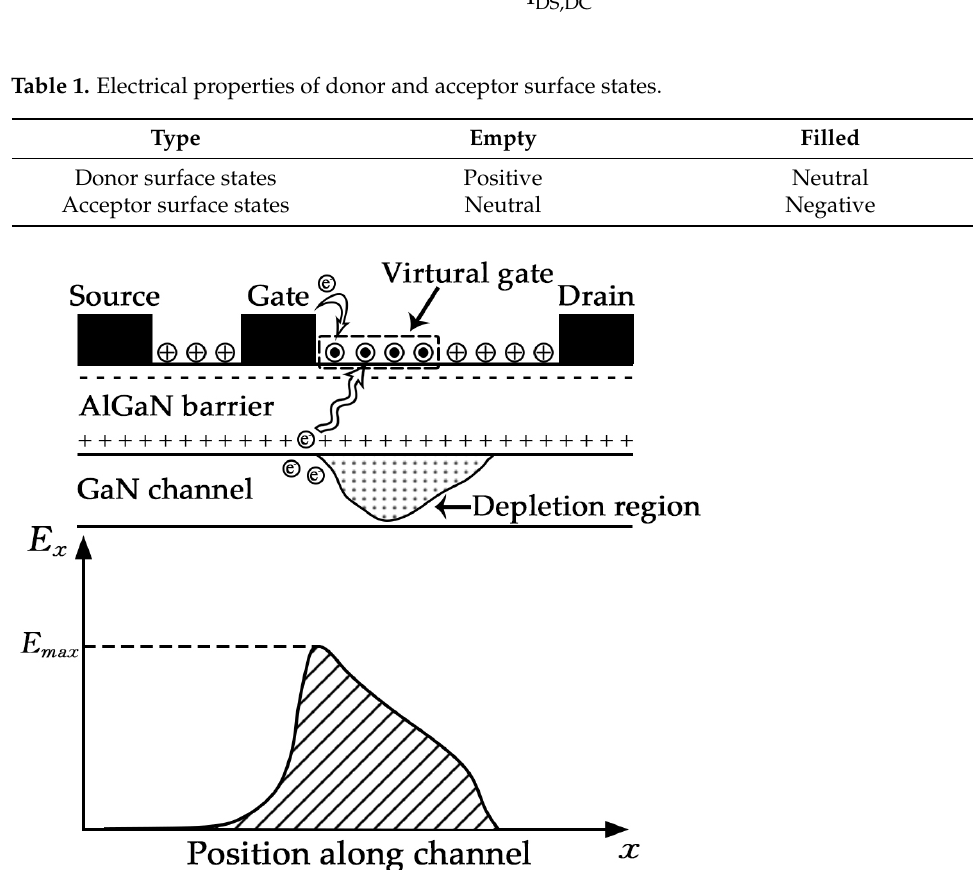
Figure 2. The device model shows the virtual gate’s location, schematic representation, and the electric field distribution in the channel.